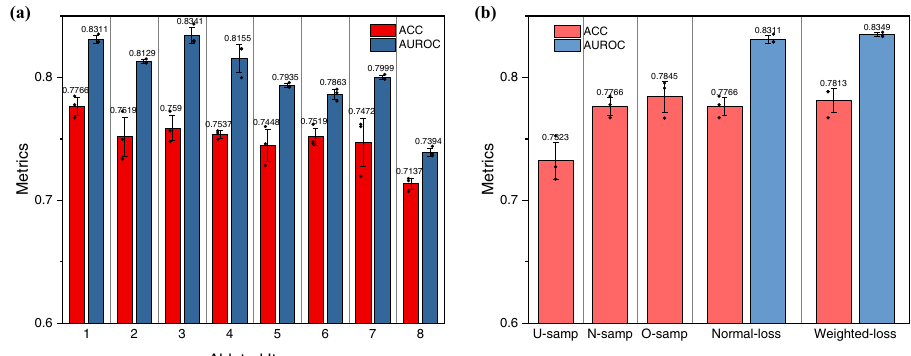
Fig. 4 | Validation of DeepPROTACs model and data balance inspection on N=2832 biologically independent samples over 3 independent experiments. Dataarepresentedasmeanvalues±SD.Thestatisticaltestusedfordataanalysisis paired t test with two-sided and no adjustments were made for multiple compar- isons. Source data are provided as a Source Data fi le. a Ablation experiments on DeepPROTACs model. Ablateditem: 1 - none,2- ligase pocket, 3 -E3ligand, 4 - POI pocket, 5 - warhead, 6 - linker, 7 - ligase pocket and E3 ligand, 8 - POI pocket and warhead. b Data balance experiments on DeepPROTACs model. Under-sampling